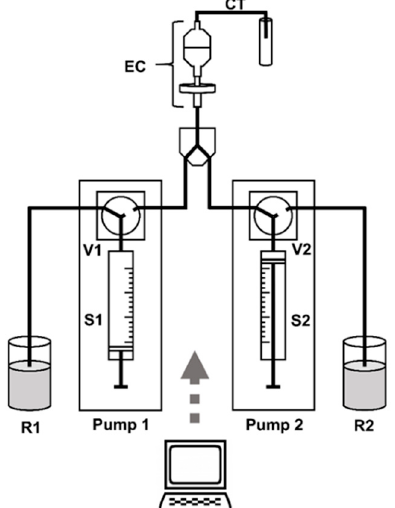
Figure 4. Schematic representation of the flow-based dynamic extraction apparatus. S1 and S2, syringes; V1 and V2, solenoid valves; EC, extraction chamber; CT, collecting tube; R1 and R2, extraction fluid reservoirs.